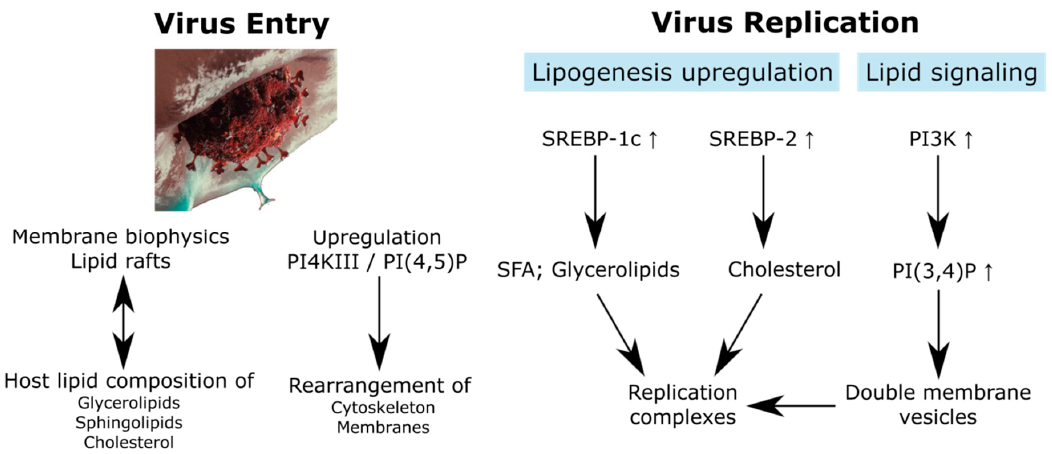
Figure 1. Relationship between the virus entry and replication with the lipidome. SREBP, sterol regulatory element binding protein; SFA, saturated fatty acid. SARS-CoV-2 artwork was modified from a work from We Are Covert , who allows anyone to use it for any purpose including unrestricted redistribution, commercial use, and